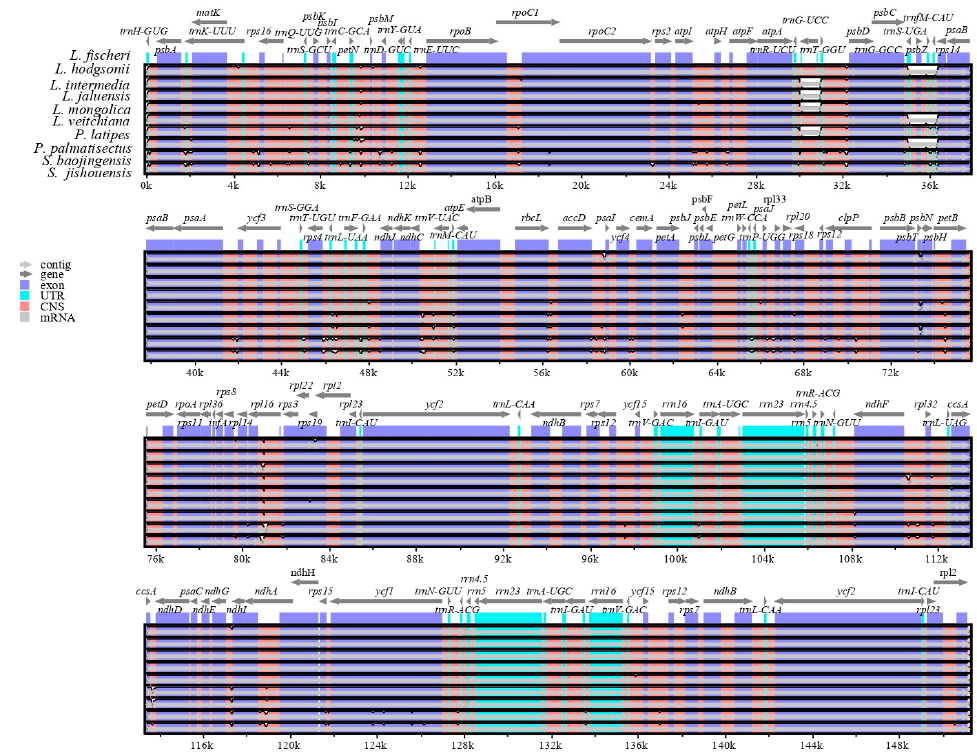
Figure 6. The homologous comparison of 10 Senecioneae plastomes by mVISTA with L. fischeri as a reference. Gray arrows and thick black lines above the alignment indicate genes with their orientation and the position of the IRs, respectively. A cut-off value of 70% identity was used for the plots, and the Y-scale represents a percent identity between 50% and 100%.